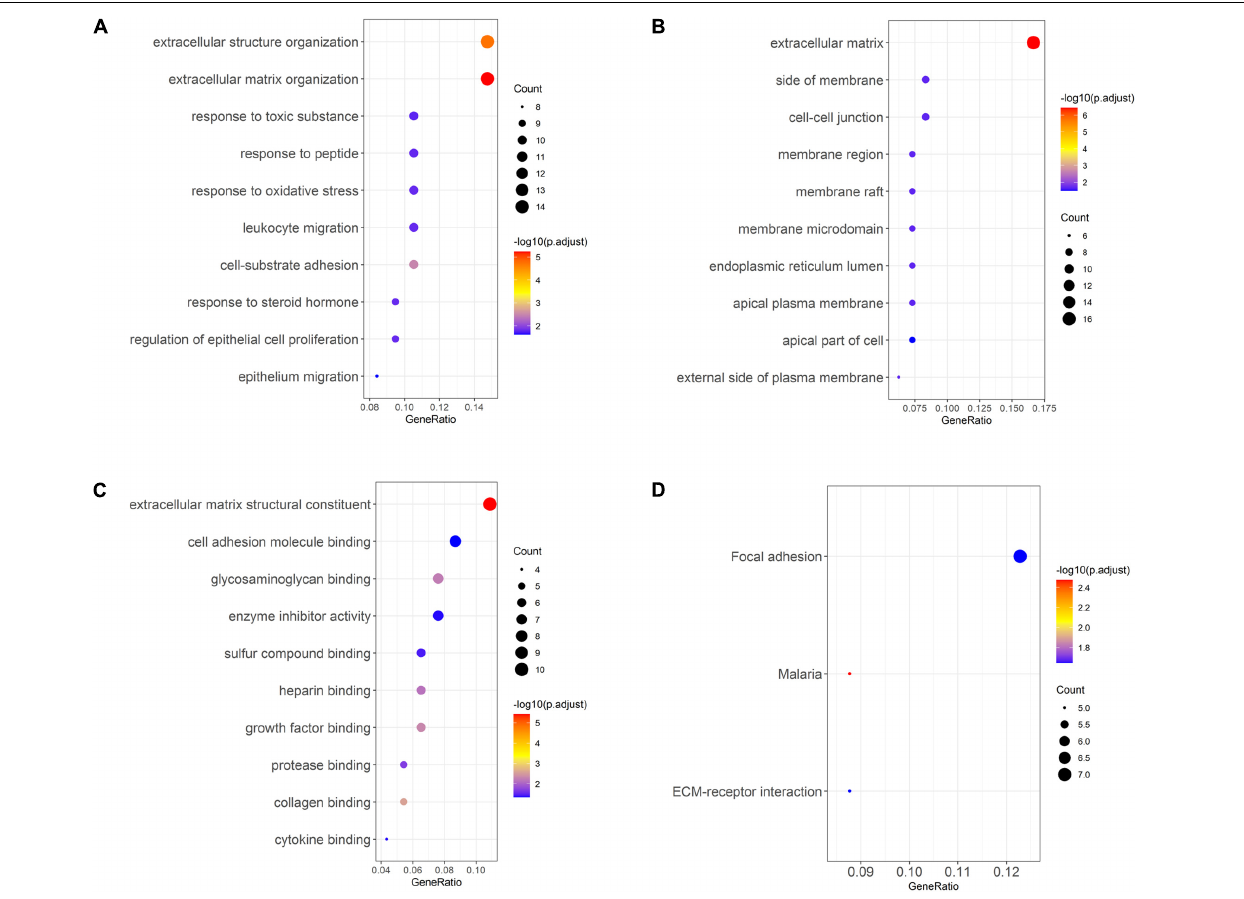
FIGURE 3 | GO and KEGG analyses of LUAD DEGs. (A–C) GO enrichment analysis of LUAD DEGs, separated for biological process (BP), cellular component (CC), and molecular function (MF); (D) KEGG enrichment analysis of LUAD